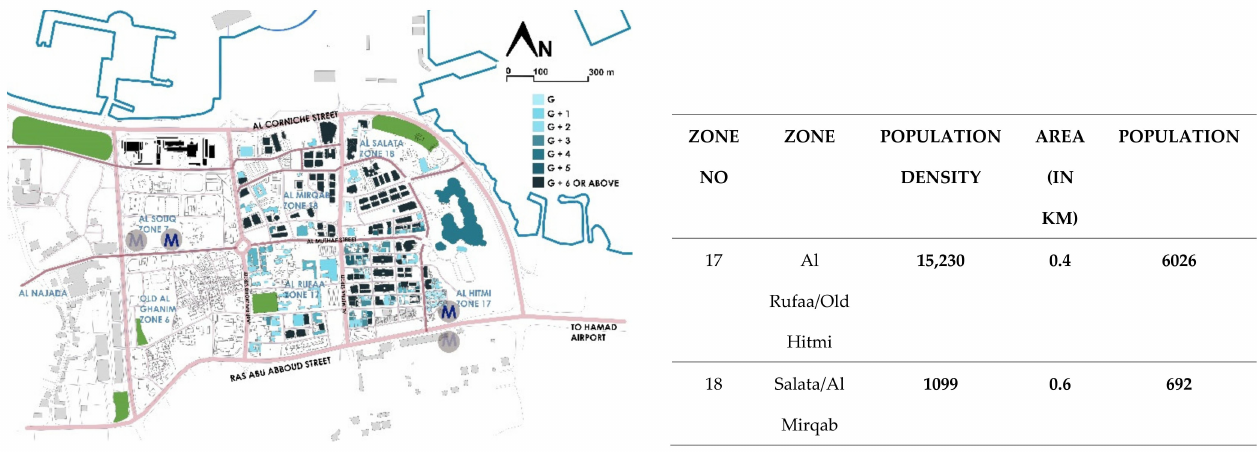
Figure 7. Building heights and population density in study